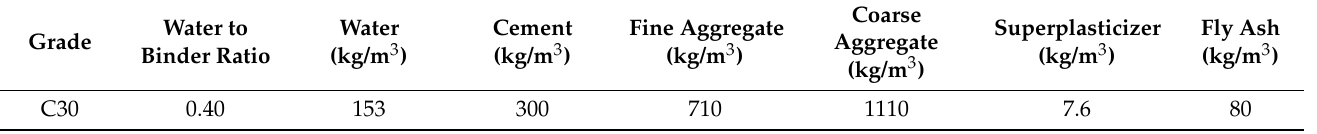
Table 3. Concrete mixture ratio.